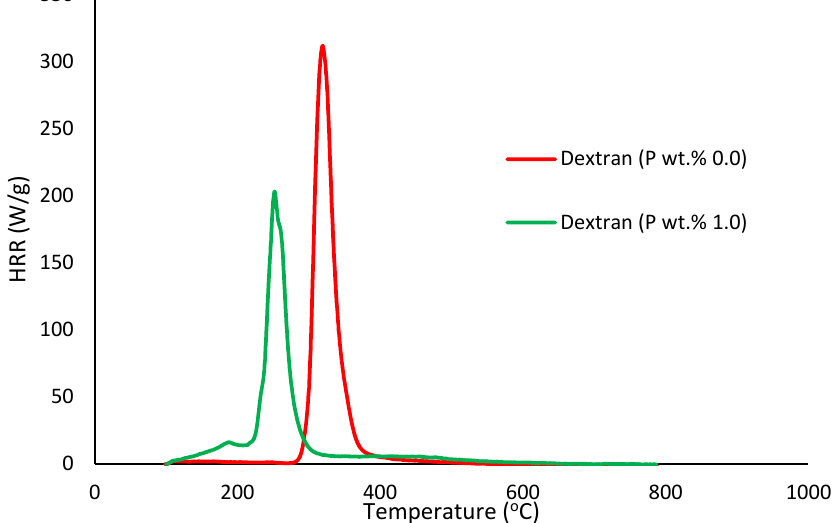
Figure 9. Plot of heat release rate (HRR) (W/g) versus temperature (°C) for modified and unmodified versions of dextran.